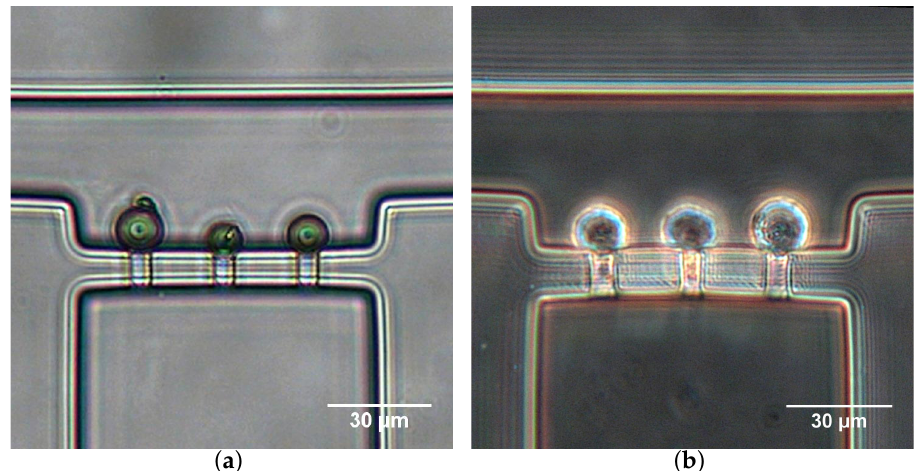
Figure 7. Microparticle ( a ) and Hela cell ( b ) trapping with micropipette aspiration channels at Q t = 40 µ L/h.